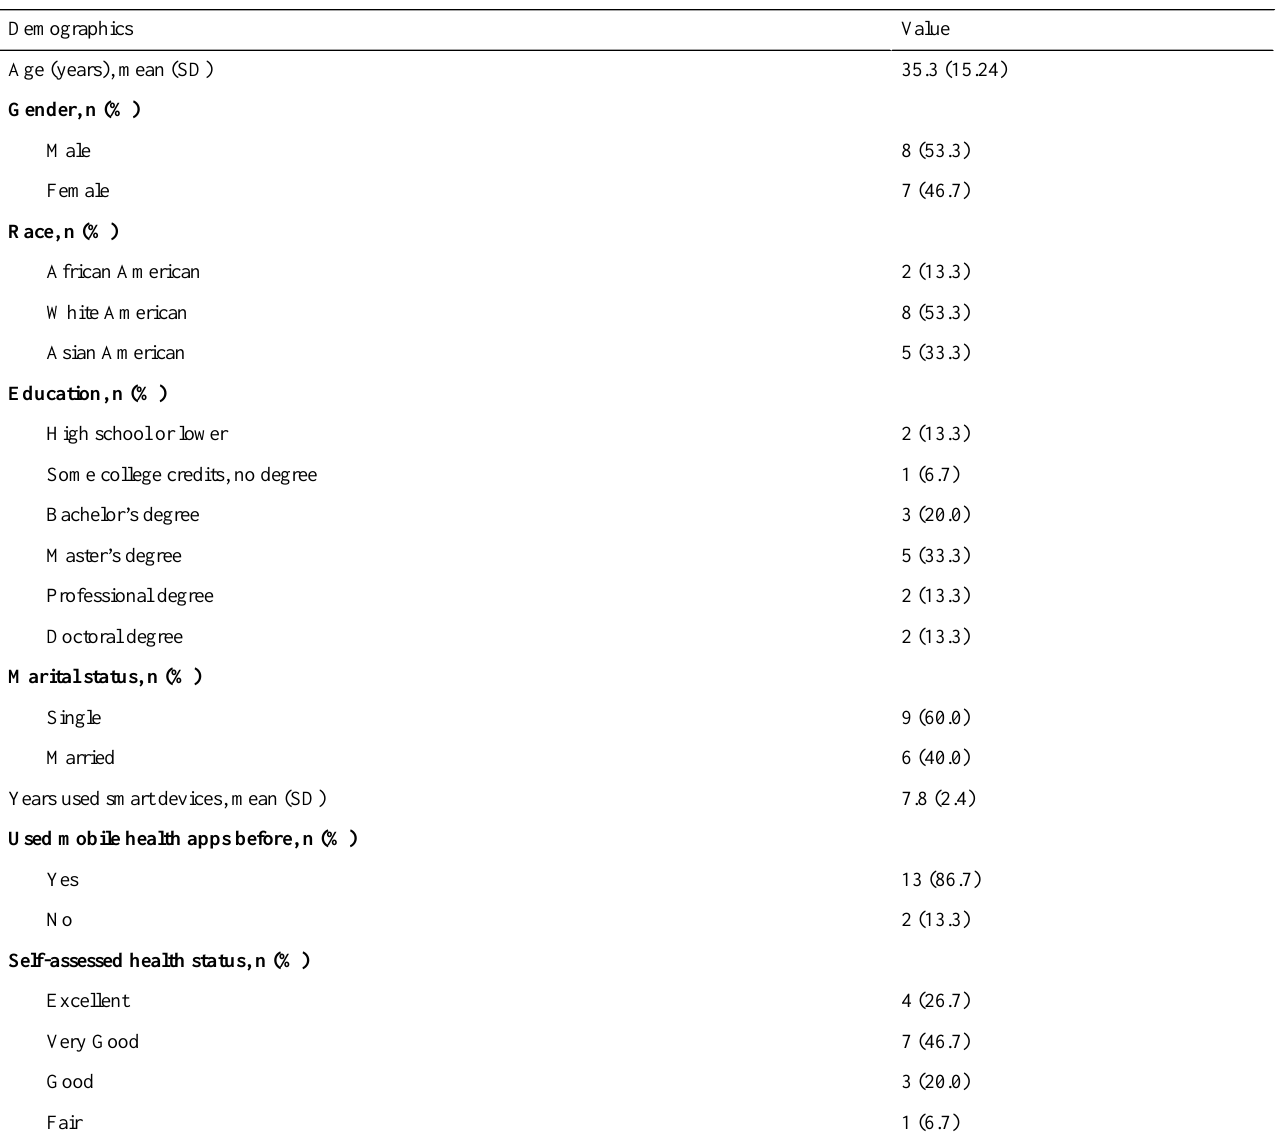
Table 3. Demographics of the usability study participants (N=15).